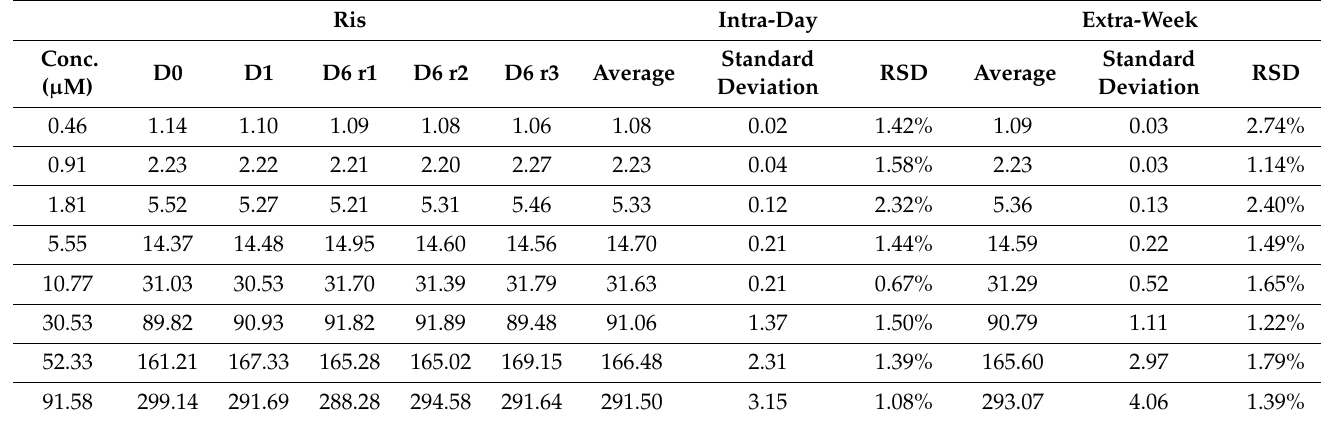
Table 4. Intra-day assay and extra-week (day 0, 1, and 6) precision of calibration curve of trehalose: